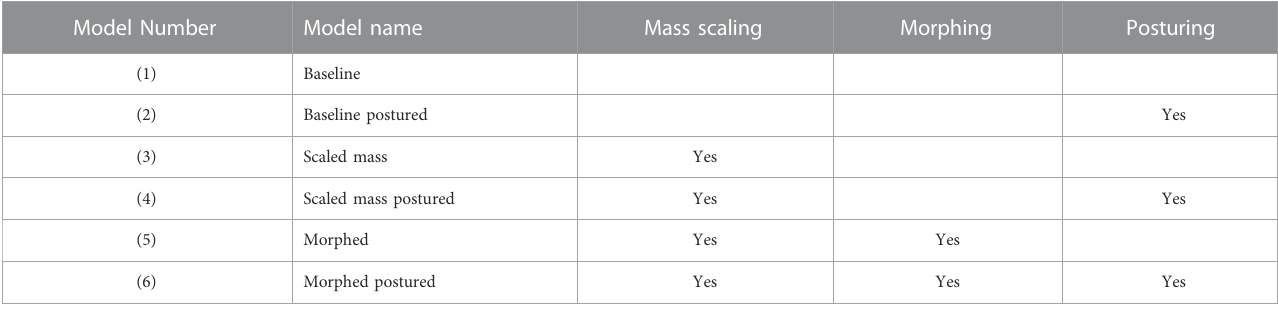
TABLE 3 Model versions and modi fi cations applied.